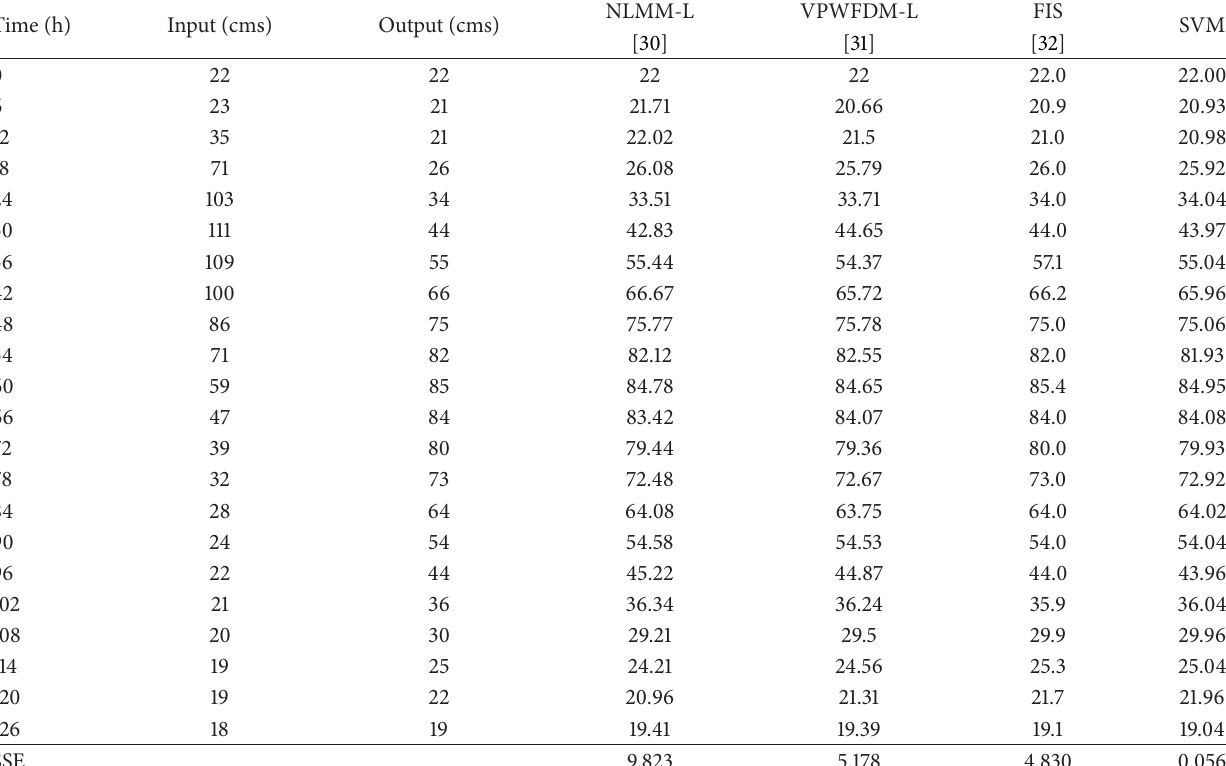
Table 1: Comparison of the observed and computed outflows for Wilson